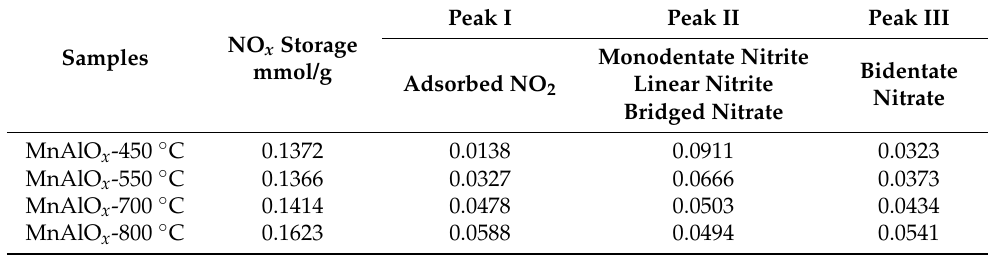
Table 2. Capacities of MnAlO x catalysts for NO x adsorption.